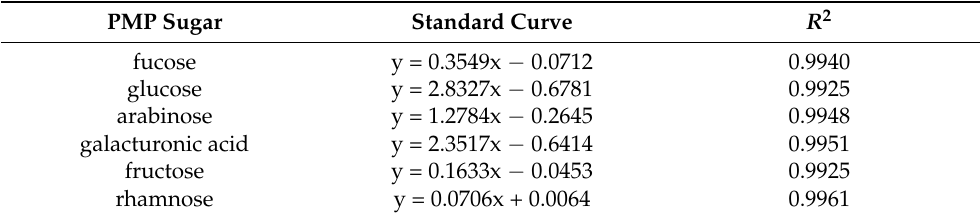
Table 1. Calibration curves for PMP